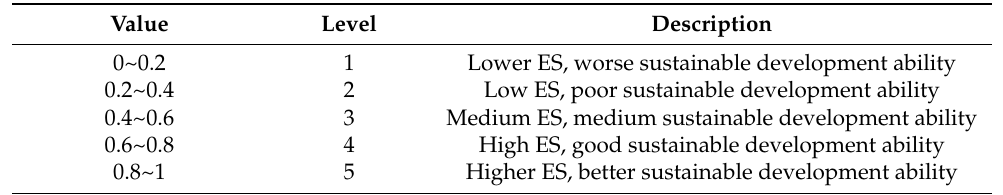
Table 2. Classification of ES assessment